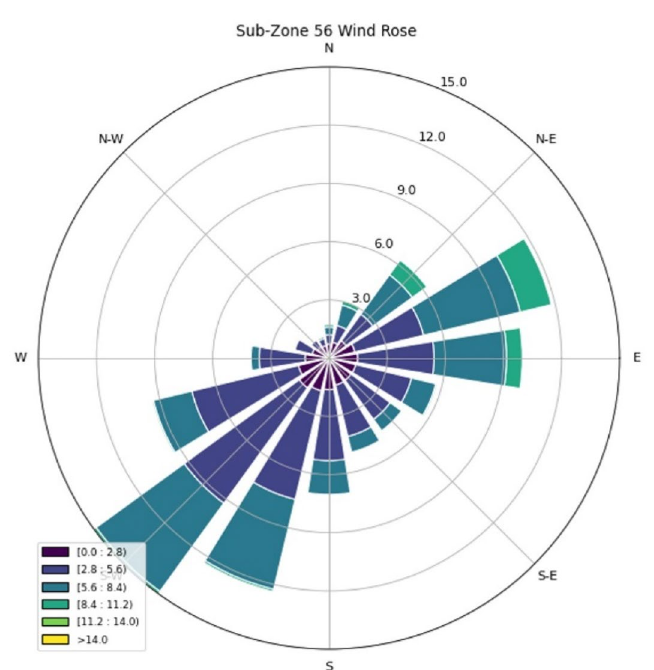
Fig. 16 Wind rose of sub-area